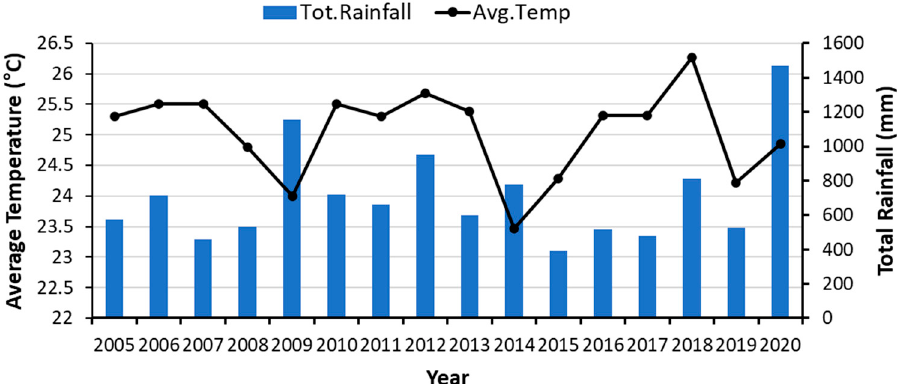
Figure 2. Average temperature and total rainfall during the rice growing season (June–August) of